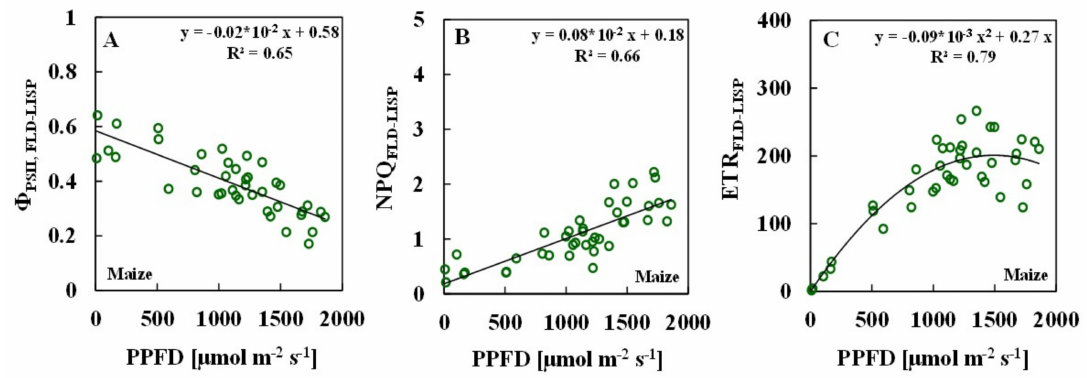
Figure 5. Relationships between the solar PPFD and the ChlF parameters ( A ) Φ PSII ; ( B ) NPQ; and ( C ) ETR of maize leaves estimated by the FLD-LISP method. The results of the PAM method were very similar and the details are given in Table